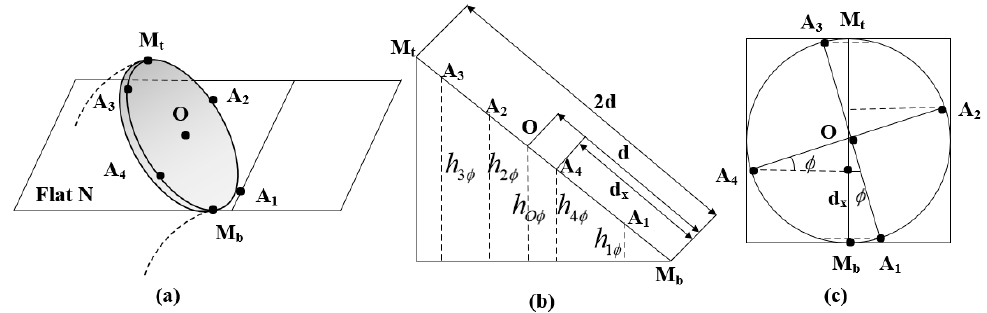
h h h h h , , , , . ( c ) Projection view of 1 2 3 4 O     